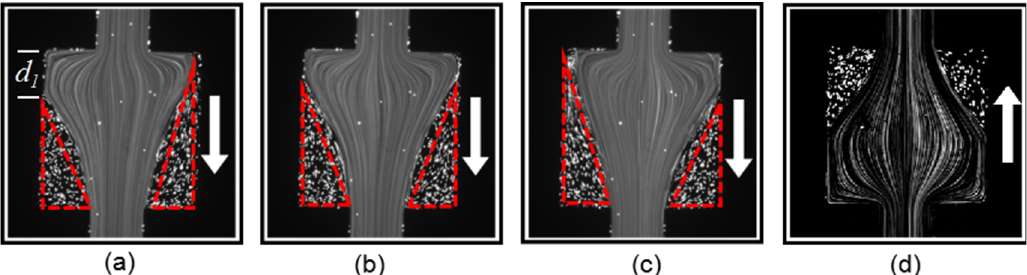
Figure 5. Viscoelastic flow pattern in the square chamber for flows along the forward direction at ( a – c ) three different instants, and ( d ) backward direction at Wi = 16.67.